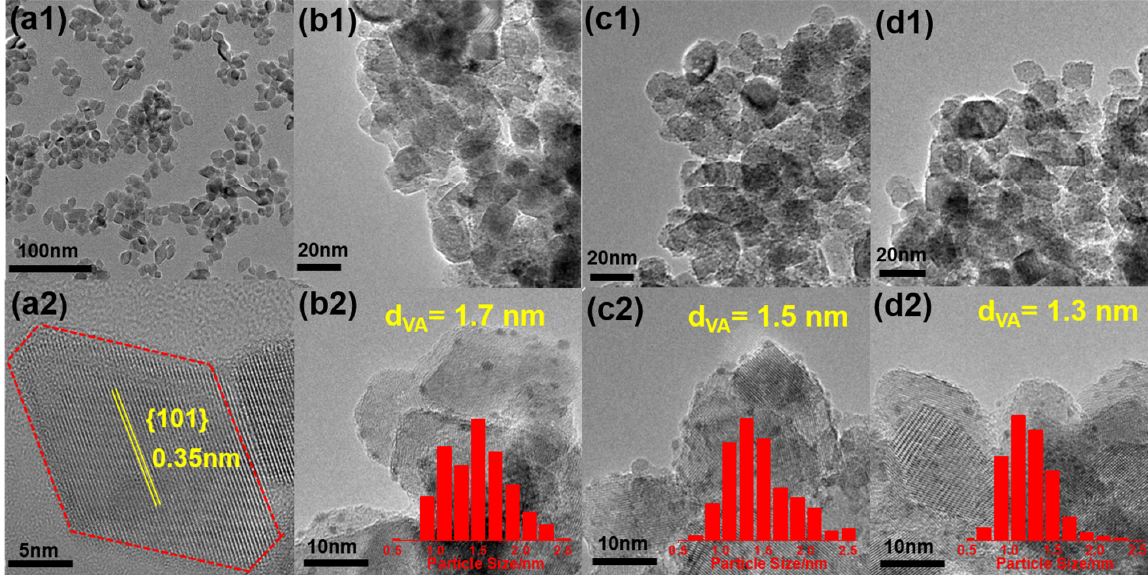
Figure 2. HRTEM images and Ir particle size distributions of ( a1–a2 ) fresh TiO 2 –{101}, pre-reduced (b1–b2 ) Ir/TiO 2 –A, ( c1– c2 ) Ir/TiO 2 –Cl and ( d1–d2 ) Ir/TiO 2 –N catalysts. The H 2 -TPR profiles for the fresh TiO 2 NCs and the Ir/TiO 2 catalysts are shown in